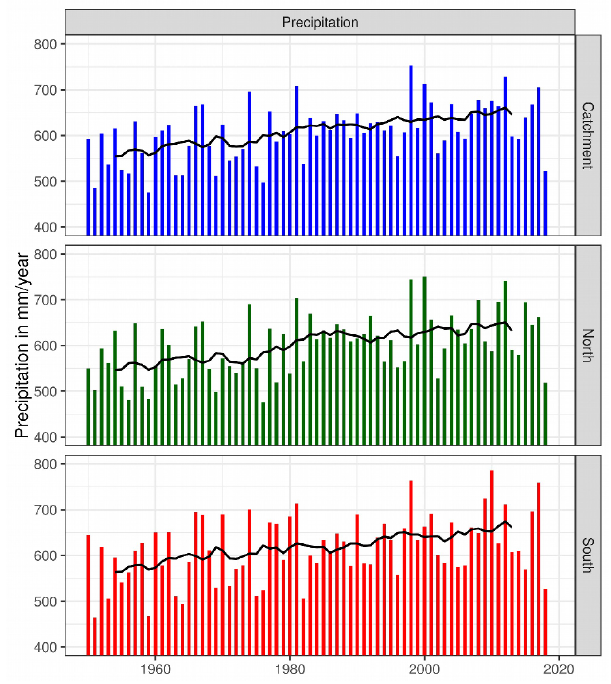
Figure 9. Mean annual precipitation over land in millimetres per year (hereafter mmyr − 1 ) in the Baltic Sea catchment area during 1950–2018. Blue is the whole catchment area, green is the area north of 59 ◦ N, red is the area south of 59 ◦ N, black is the 10-year running mean, and the bars are the annual sum. Data source: http://surfobs.climate.copernicus.eu/dataaccess/ access_eobs.php#datafiles (last access: 17 February 2022). Trends are as follows: 1.44mmyr − 1 (total), 1.51mmyr − 1 (north), 1.37mmyr − 1 (south), and significant at 99%, using the phase- scrambling method (Kniebusch et al.,